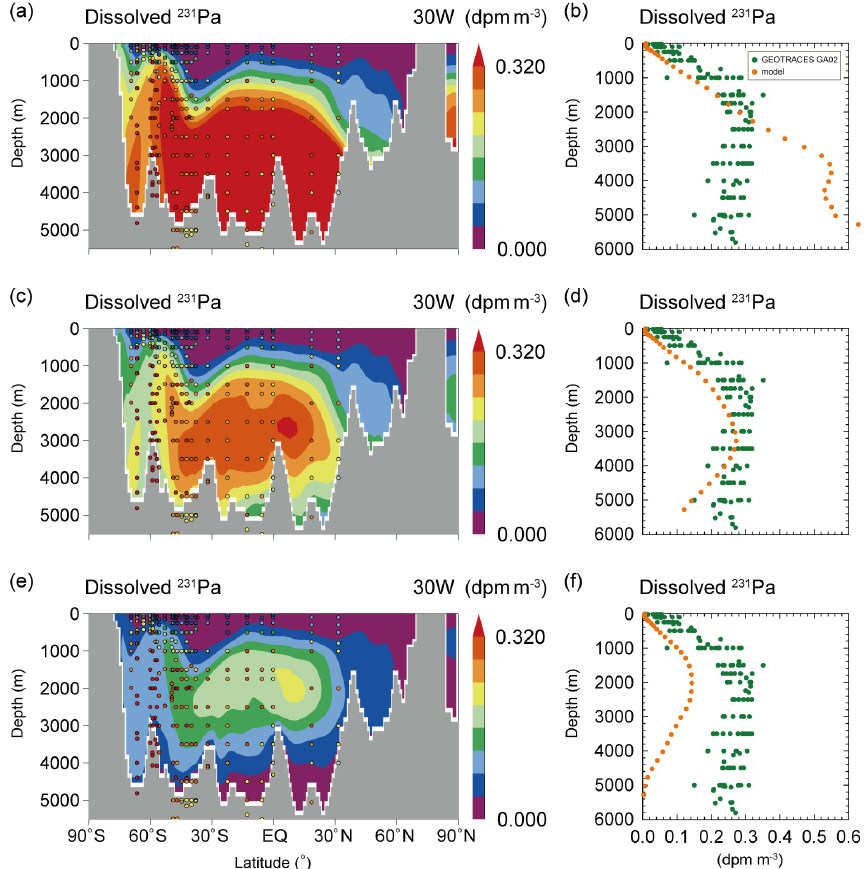
Figure 2. (a, c, e) Dissolved 231 Pa along 30 ◦ W in the Atlantic Ocean and (b, d, f) its vertical profile (the latitudinal mean along 30 ◦ W in the Atlantic Ocean) in BTM EXP. K Pa is set to 5 . 0 × 10 4 in (a) and (b) , 5 . 0 × 10 5 in (c) and (d) , and 5 . 0 × 10 6 in (e) and (f) . The colored bottom circles in (a) , (c) , and (e) represent data from the Atlantic GEOTRACES data (GA02 and GIPY05; Schlitzer et al., 2018). The green and orange circles in (b) , (d) , and (f) represent the GA02 data and simulation results.